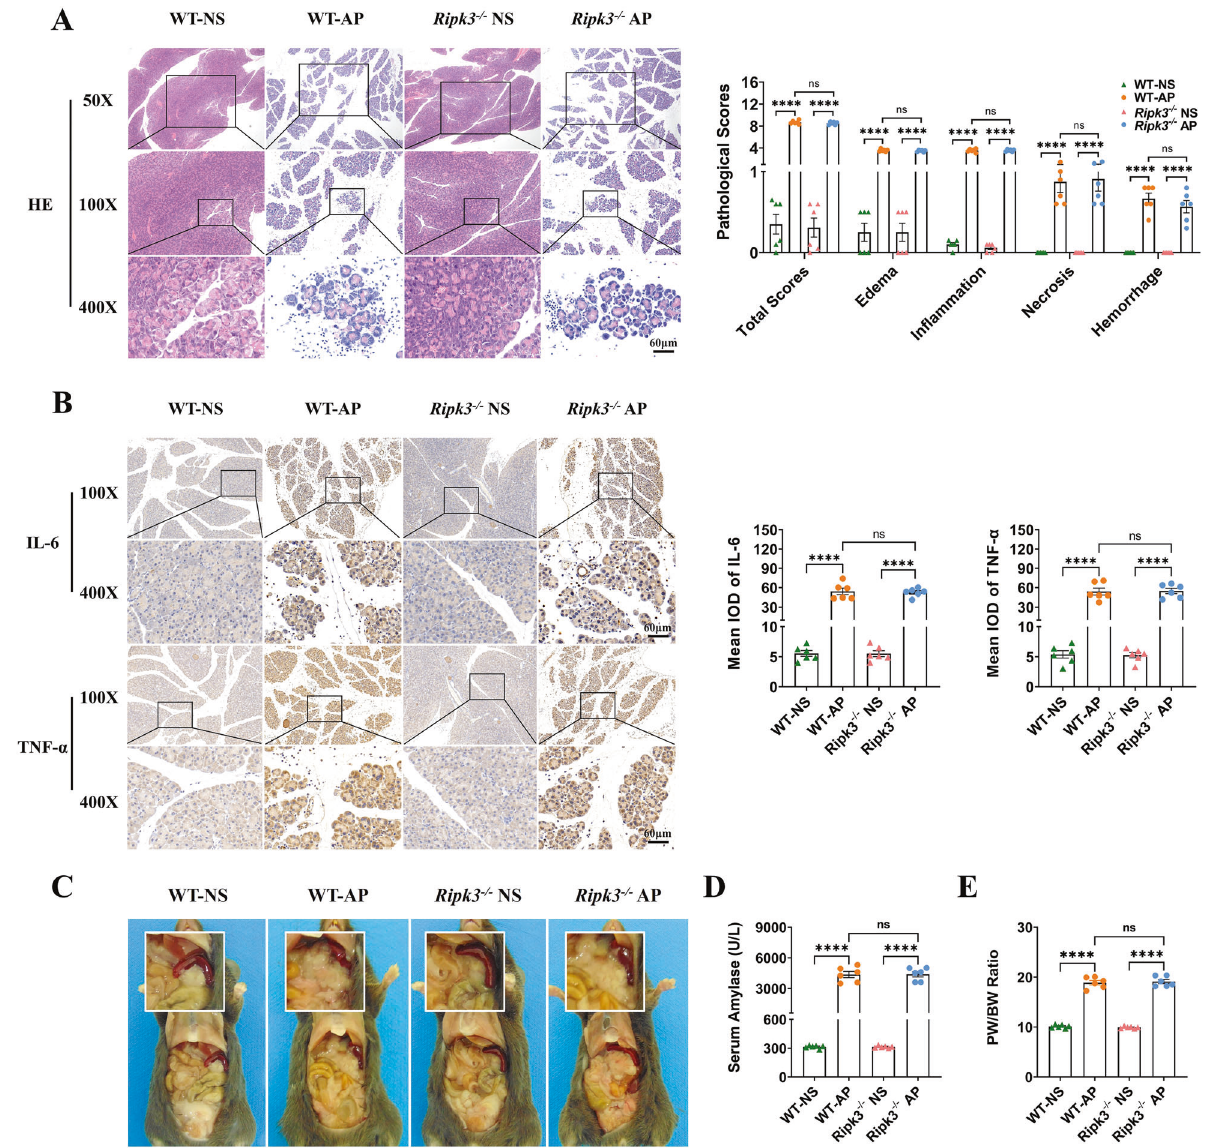
Fig. 3 Knockout of Ripk3 did not exert protective effects against AP in mice. The pancreatic pathological scores, expression of in fl ammatory mediators including IL-6 and TNF- α , extent of pancreatic edema, and level of serum amylase were not signi fi cantly different between WT and Ripk3 -/- mice with AP. A HE staining and pancreatic pathological scores of the pancreas ( n = 6). B Immunohistochemical staining of TNF- α and IL-6 in the pancreas ( n = 6). C Gross morphology of the pancreas ( n = 6). D Serum amylase ( n = 6). E The ratio of pancreas weight to body weight ( n = 6). Values are shown as the means ± SEMs. ns, not signi fi cant; * P < 0.05; ** P < 0.01; *** P < 0.001; **** P < 0.0001. WT wild type, IOD integrated optical density, NS normal saline, AP acute pancreatitis, PW pancreas weight, BW body